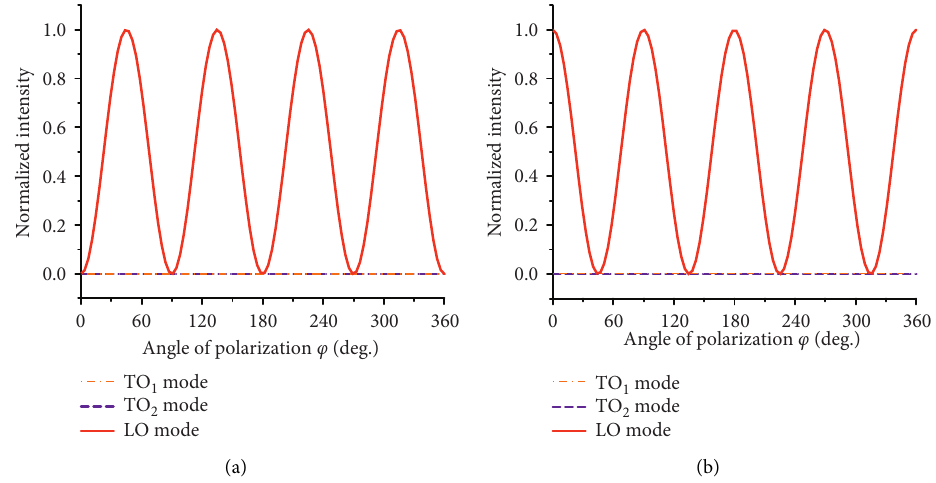
Figure 3: Raman intensity distribution of vertical backscattering for the (a) HH case and (b) HV